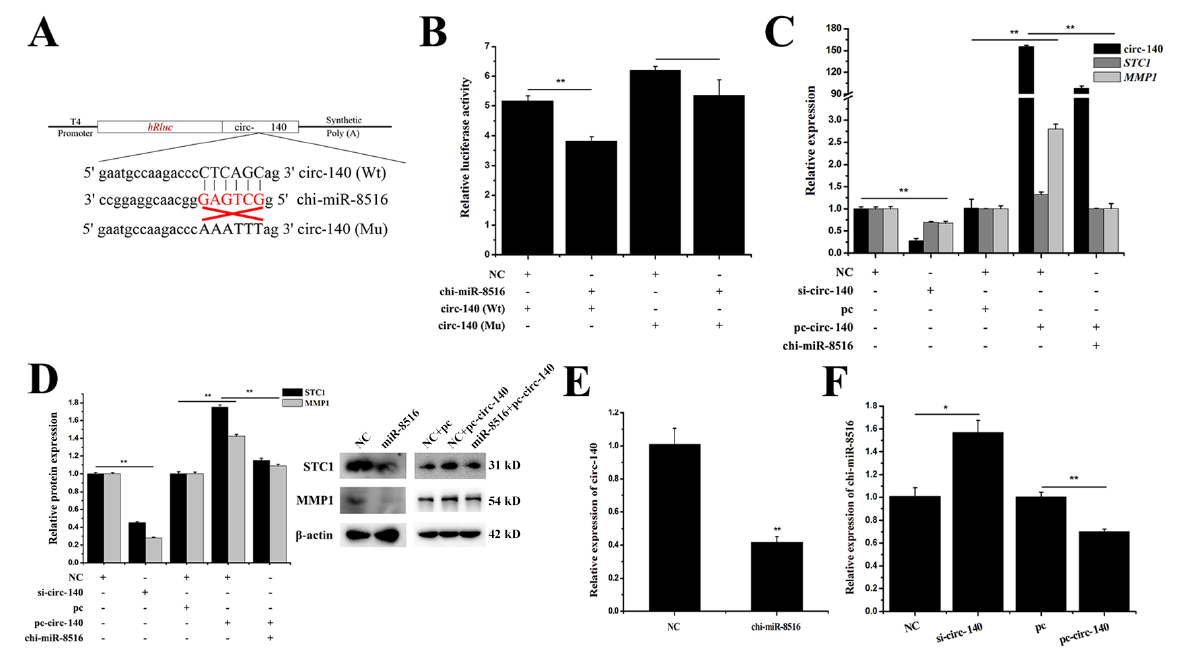
Figure 3. The relationship between circ-140 and chi-miR-8516 and the effect of circ-140 on STC1 and MMP1 expression. ( A , B ) Information on circ-140 Wt and Mu luciferase reporter vectors and relative luciferase activity upon co-transfection with chi-miR-8516 or NC; ( C , D ) the efficiency of si-circ-140 and pc-circ-140, and the regulation of STC1 and MMP1 mRNA and protein expression by circ-140; ( E ) the regulation of circ-140 by chi-miR-8516; ( F ) the effect of circ-140 on the expression of chi-miR-8516. * p < 0.05; ** p <